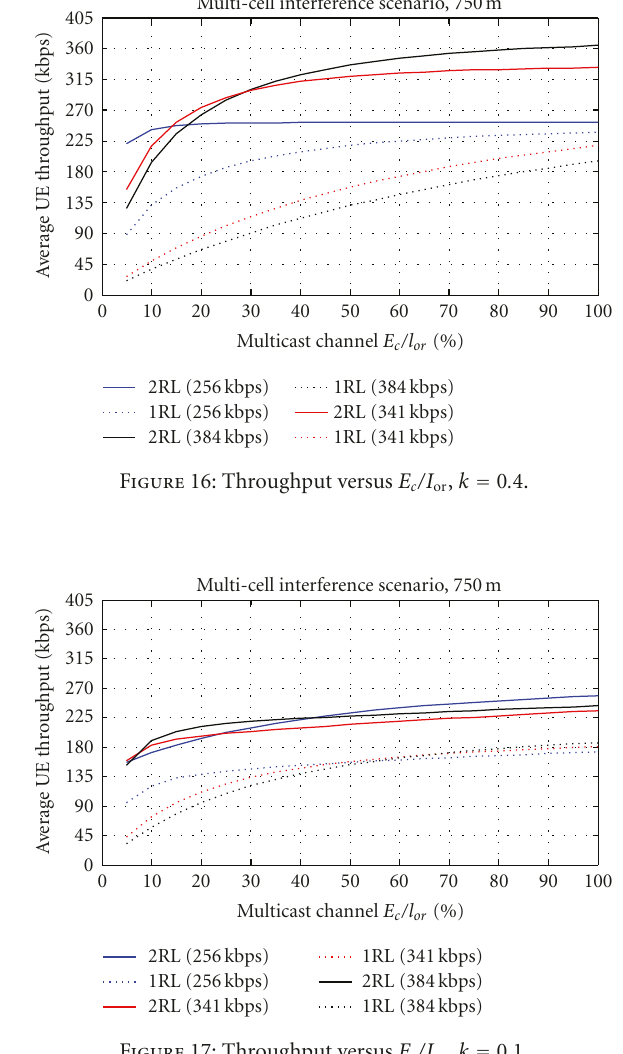
Figure 17: Throughput versus E c /I or , k = 0 .